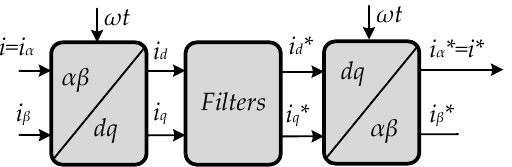
Figure 2. A diagram of the algorithm for determining the reference current in each phase.